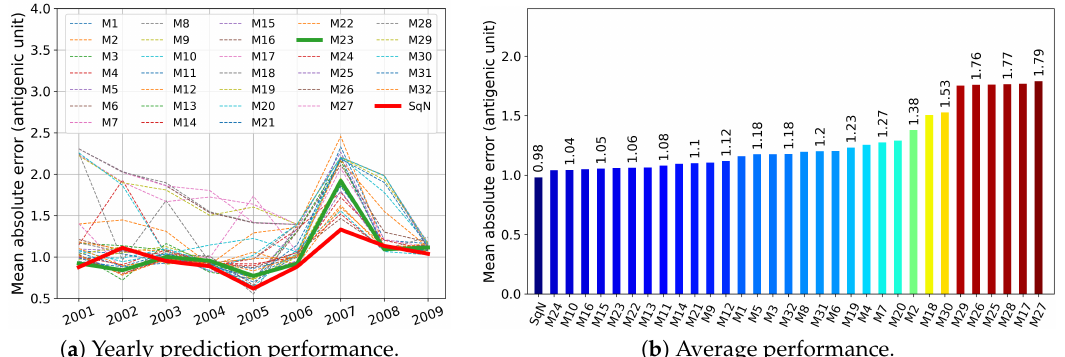
Figure 11. Experiment T 4 : the models were trained on a four-year prehistory.